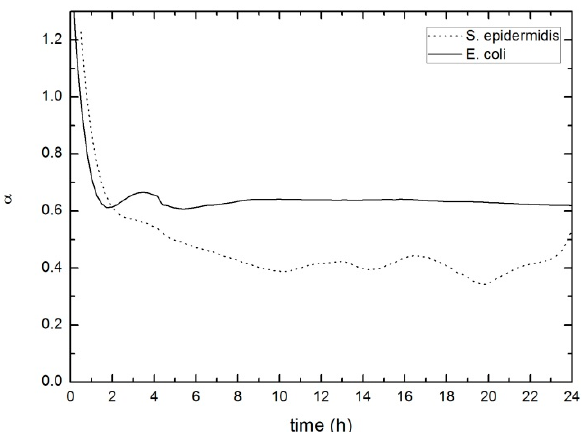
Figure 12. Evolution of the power-law exponent – α - for the biofilm formed by S. epidermidis (dot line) and by E. coli (solid line).